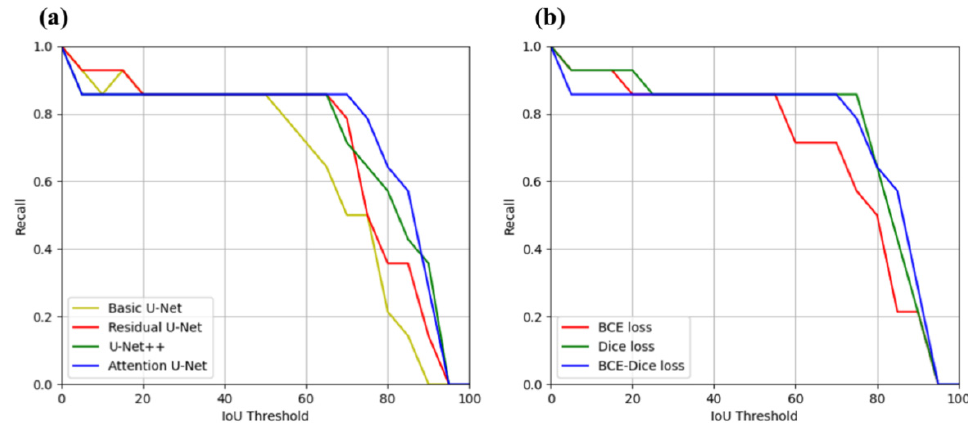
Figure 5. Recall–IoU curves: ( a ) Comparison of the four deep learning-based segmentation models